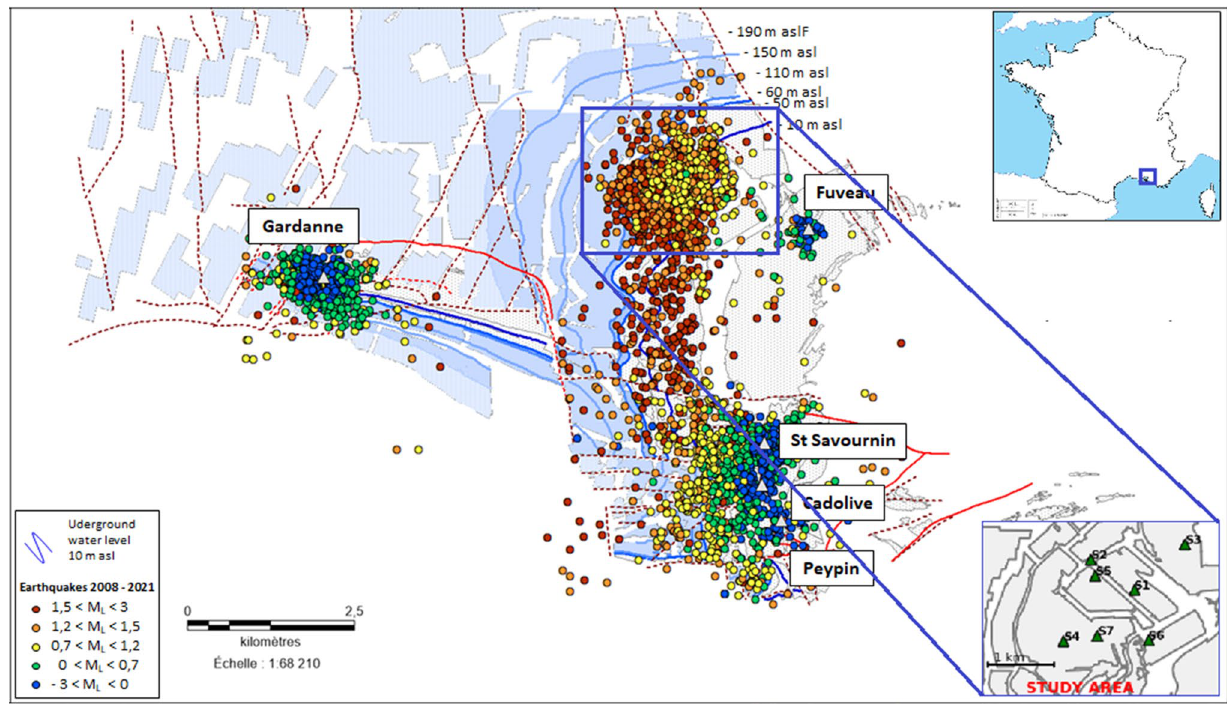
Fig. 1 Flooded abandoned Gardanne mine with observed seismic- ity and monitoring networks. Stations of permanent monitoring network are marked with white triangles and the names are written next to it, accordingly. Temporary network installed in study area is shown within inset figure in lower right corner, where grey areas indi- cate excavated parts of mine. Flooded part of mine works shown in blue. Seismicity shown as a function of magnitude by colored dots,